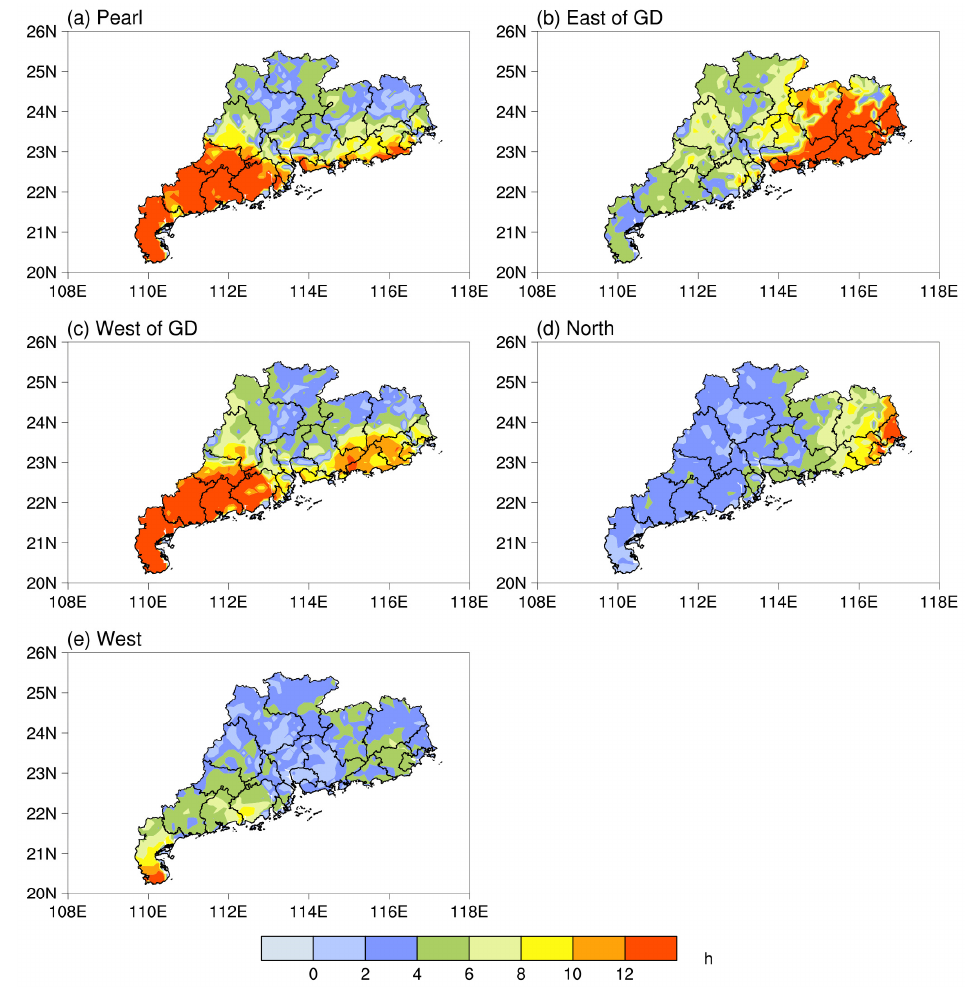
Figure 5. The same as Figure 4, but for the cumulative flood duration. Figure 6 depicts the spatial distributions of the average cumulative flood intensity; the blue lines indicate the river channels in Guangdong. When typhoons made landfall in the Pearl River Delta region, high flood intensity appeared in western Guangdong. For typhoons that landed on eastern Guangdong, the related high flood intensity appeared in the river areas of northern and eastern Guangdong, and in the low-lying coastal areas. When typhoons made landfall in western Guangdong, high flood intensity appeared in the areas with low terrain in western Guangdong and some small low terrain parts of northern and eastern Guangdong. For the non-landing typhoons that moved northward, the related high flood intensity appeared in the river areas of northern and eastern Guangdong. For the non-landing typhoons that moved westward, the related high flood intensity appeared in some small low terrain regions. In contrast to flood duration, flood intensity does not show a similar spatial distribution as precipitation, and appears to be more related to landform. Time series plots can depict more clearly the variations in precipitation and floods during the typhoon period (Figure 7). Here the data were standardized for comparison. For the typhoons that landed on the Pearl River Delta region, the average precipitation of all areas of Guangdong showed a rising tendency during the 0 to 24 h period; the precipitation reached its peak at 24 h, and then decreased with time. The 24 h corresponds to the timeframe in which the typhoons make landfall; therefore, it is of great importance to focus on the high precipitation areas in Guangdong during the time that typhoons make landfall. Flood duration reached its peak at 33 h, about 9 h after the precipitation peak; this means that high precipitation will have a lagged impact on floods. Flood intensity reached